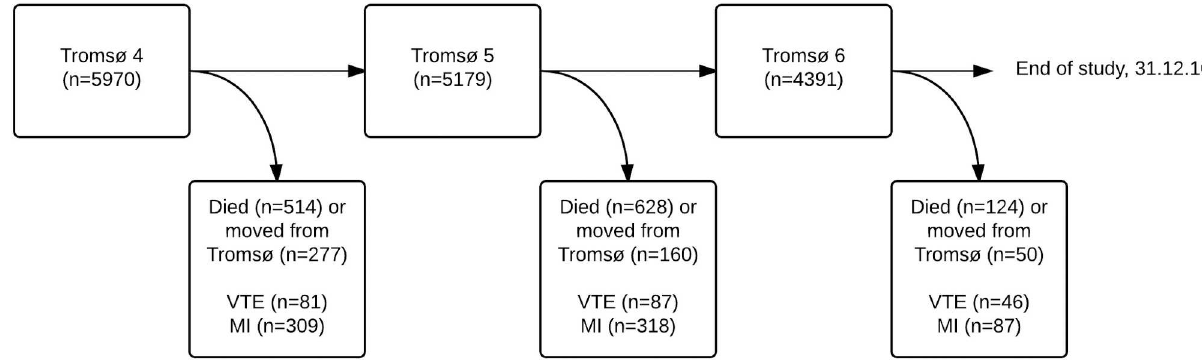
Fig 1. Study population. Study population recruitedfromThe Troms ø Study, 1994–2010. Figureshowing the common,“basic”,population in each analysis, and numberof incident VTE and MI events (separateanalyses for each